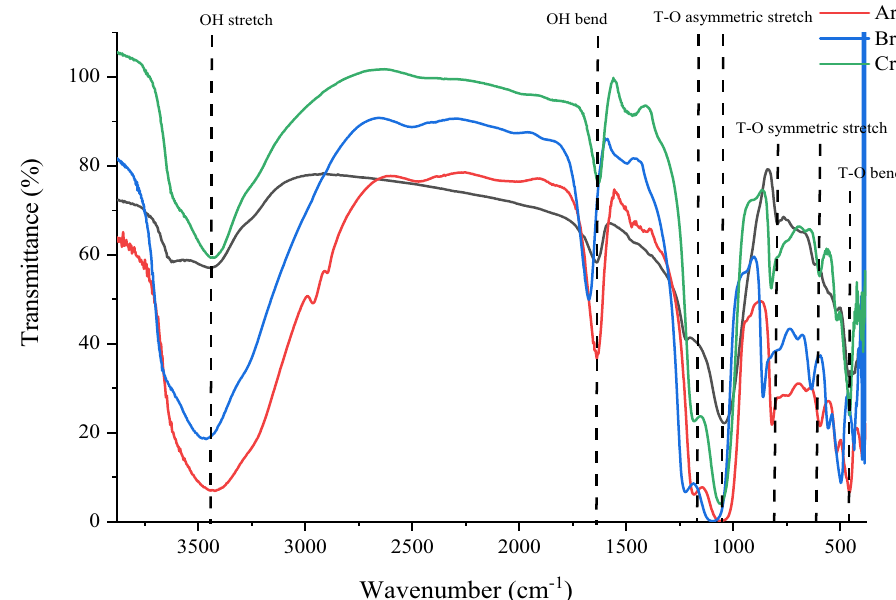
Figure 4: FTIR spectra of catalysts after the reduction